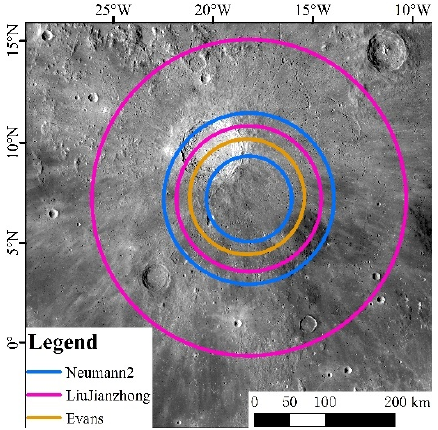
Figure 3. Previous studies of the C-H basin, as shown on the LROC WAC Global Morphology Mosaic. Blue circles from Neumann et al. [16]; pink circles from Evans et al. [13]; orange circle from Liu et al. Most of the basin rim and the peak-ring disappeared from the lunar surface. How- ever, at the north-eastern part of Neumann’s basin rim, two rims are still visible, as can be observed in Figure 4. Both surviving rims are about − 1140 m high.